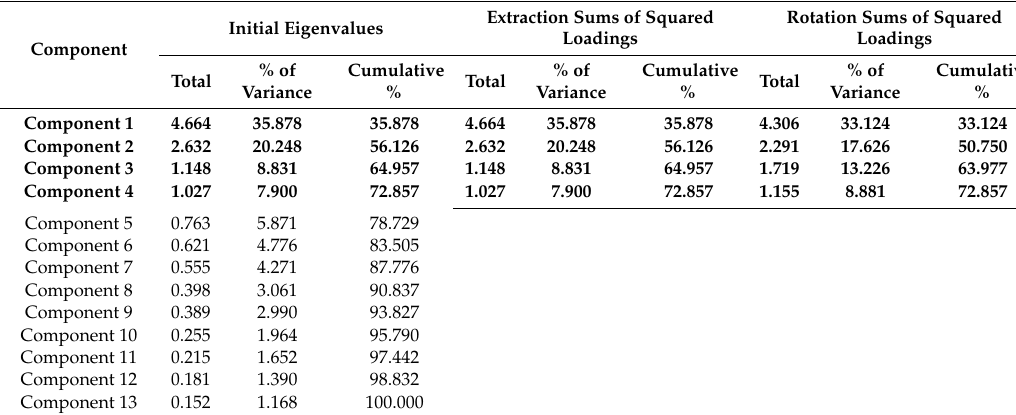
Table 1. Explanation of the Total Variance in Derivation of Health Opportunity Index. The first component, PC1 explained 35.878% of the total variance while the cumulative variance of the four retained components summed to 72.857% based on the eigenvalue (1 or